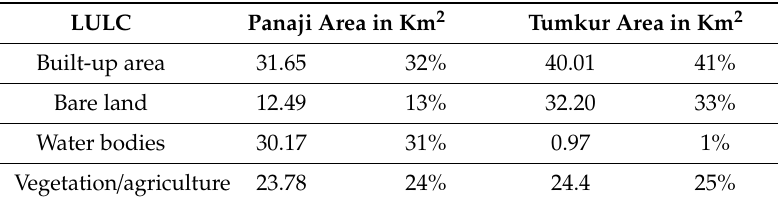
Table 3. Share of satellite-derived land use / land cover (LULC) for Panaji and Tumkur areas covered for this study.